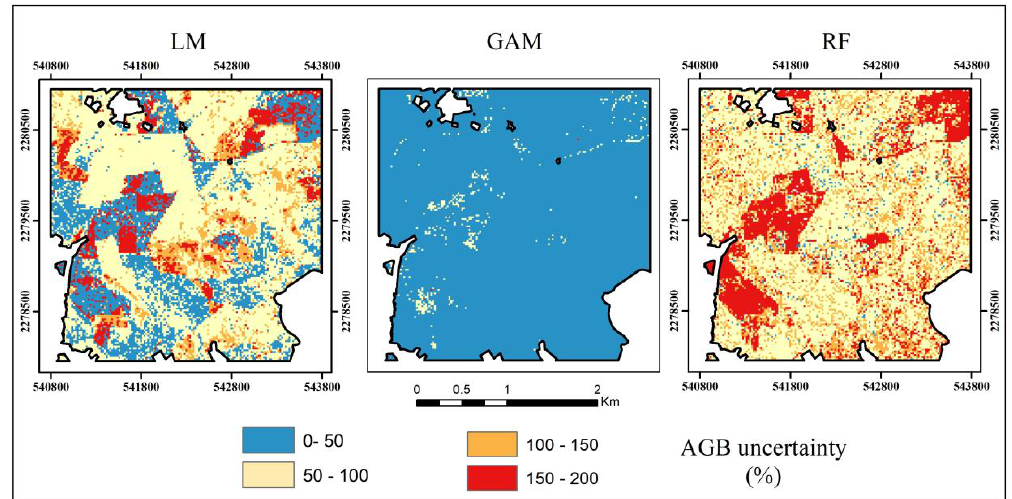
Figure 9. Distribution of AGB uncertainty (%) expressed in standardized form as the range of the 95% confidence intervals divided by their mean by LM (Linear Model), GAM (Generalized Additive Model), and RF (Random Forest) at the managed forest landscape in the Zacualtipán forested region (3 × 3 km area). Developed areas and areas without forest vegetation were excluded.